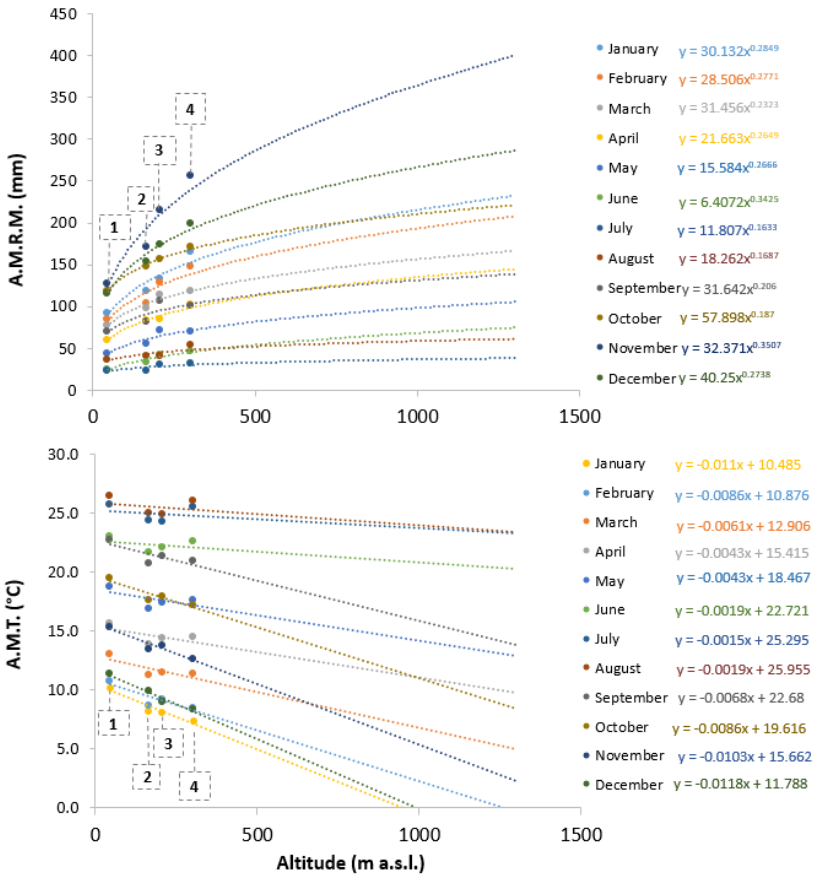
Figure 13 . Rainfall–altitude relationship (top) and temperature–altitude relationship (down), for each month of the year. The thermo-pluviometric stations are: 1—Gaeta (45 m a.s.l.); 2—Itri (165 m a.s.l.); 3—SS. Cosma e Damiano (206 m a.s.l.); 4—Esperia (302 m a.s.l.).